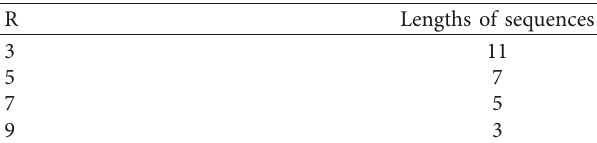
Table 5: Time resolutions ( R ) and lengths of corresponding downsampling sequences.